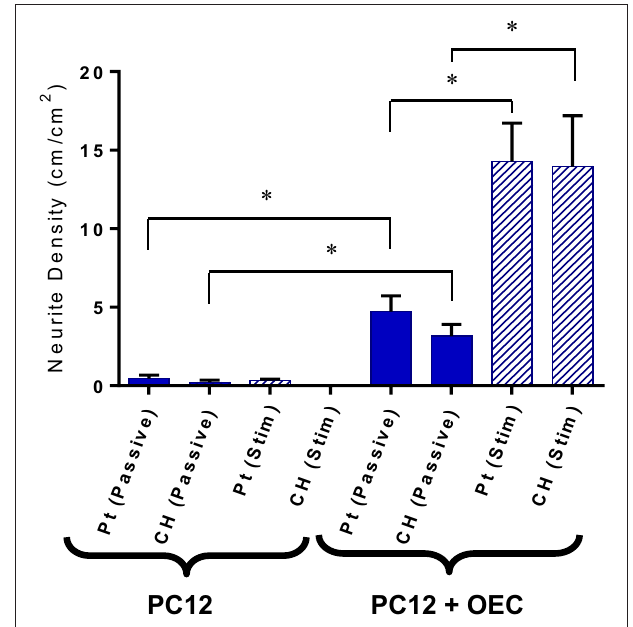
cultures with and without OECs on passive and electrically stimulated Pt and CH electrodes. Statistical analysis was in the form of Tukey one-way ANOVA. *Shows significant differences for p < 0.05. Error bars represent the standard error of the